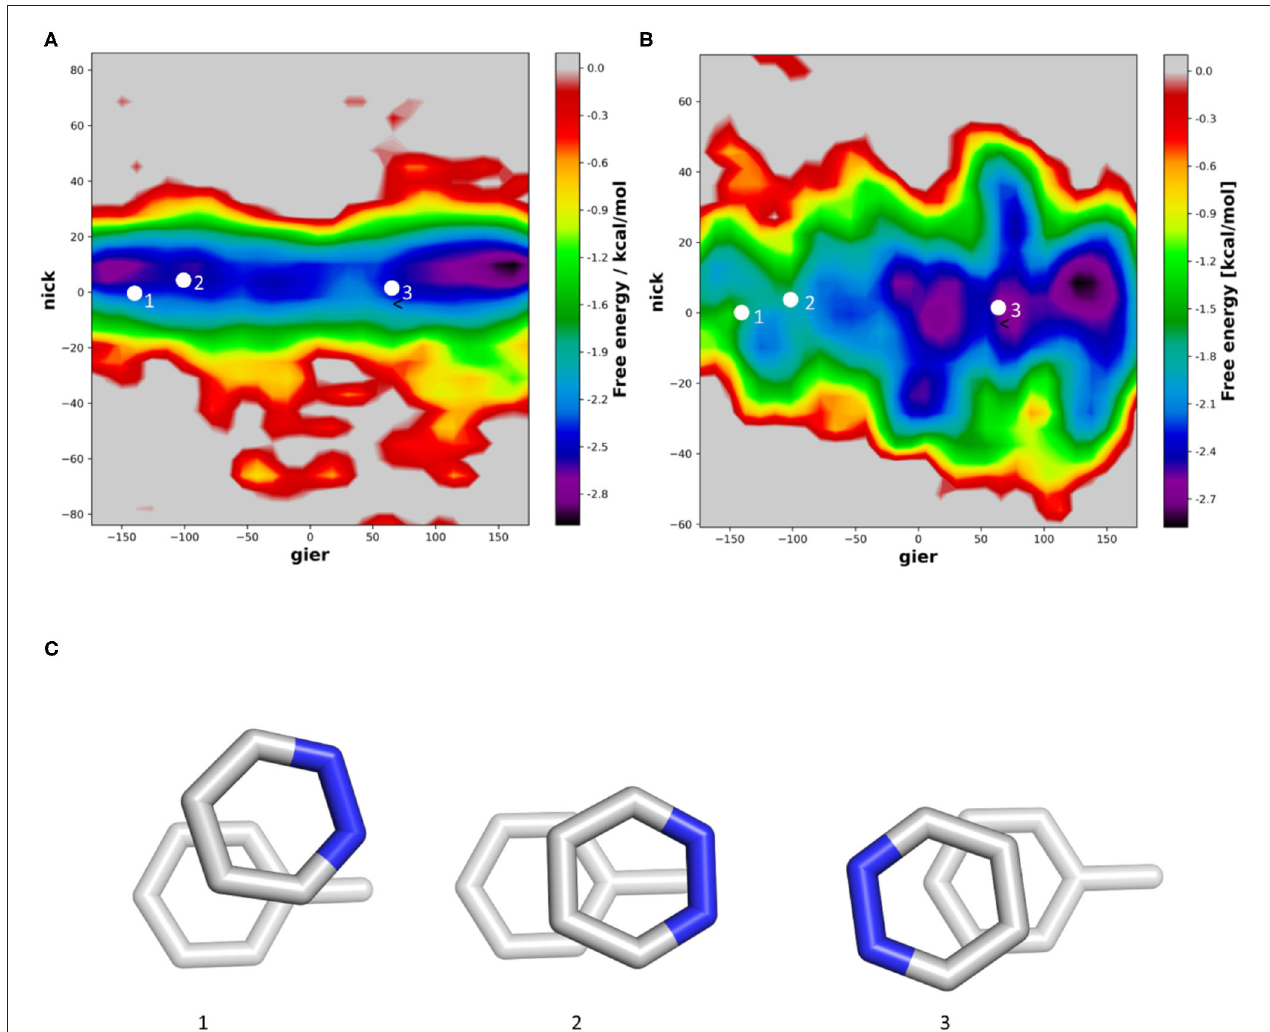
FIGURE 5 | 2D histogram analysis of the nick and gier angles of pyrazine in molecular dynamics simulations stacked with toluene. Simulations were performed in vacuum (A) and using explicit solvation (B) . We projected the orientations from published geometry optimizations in vacuum (C) into the density surface.